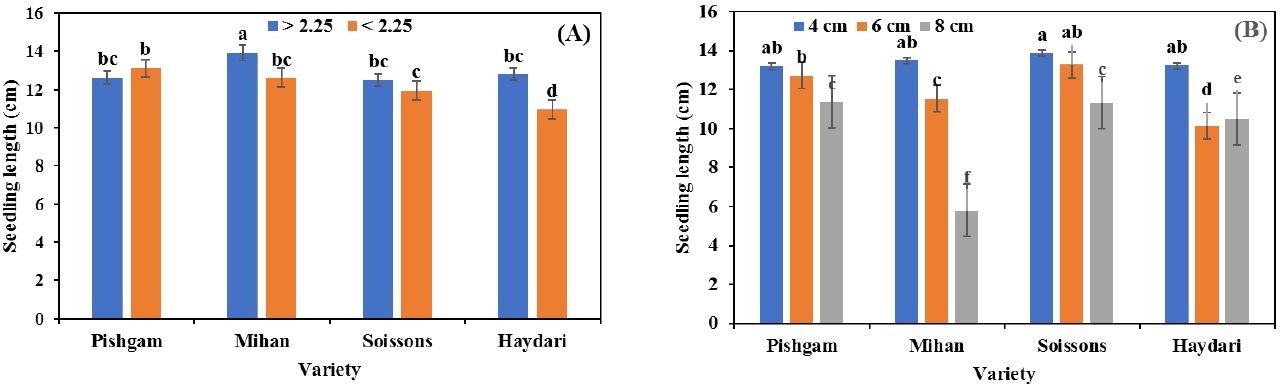
Figure 8. Effect of seed size ( A ), cultivar and depth of sowing ( B ) on seedling length. The columns’ letters indicate the differences between the different treatments ( p < 0.05) using the LSD test. The percentage and speed of germination, and vigor index, were all affected by seed size, disinfection, and depth of sowing, in all cultivars (Table 3). The highest values for germination percentage (93.75 ± 5.1%,), speed of germination (0.94 ± 0.05 seeds per day), and vigor index (13.78 ± 0.68), were obtained in non-disinfected seeds of the Pishgam cultivar atthe shallower sowing depth (4 cm), using large seeds (Table 4). The lowest 8 cm depth, with seed disinfection, using the smaller size seeds (Table